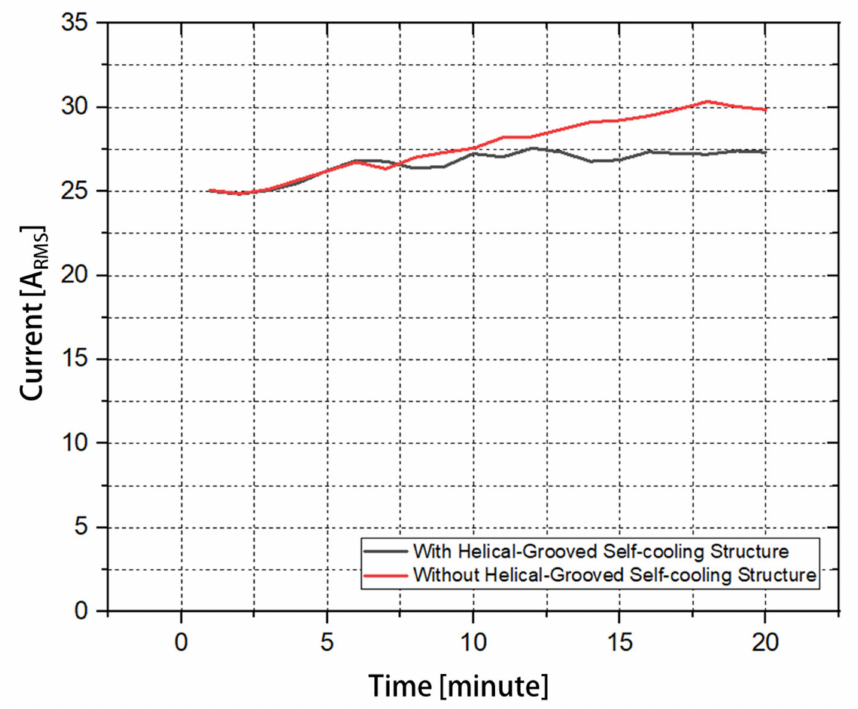
Figure 13. Motor U-phase current